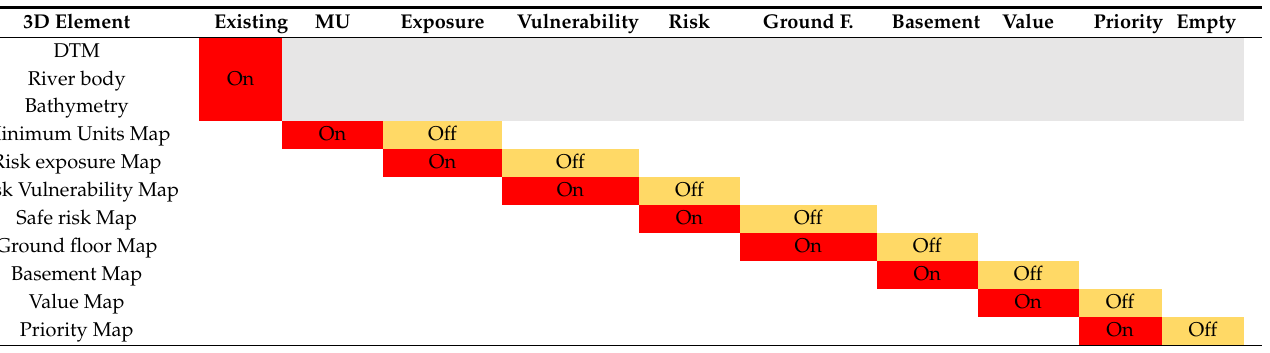
Table 2. Visualization grid of the 3D Maps using the project phases. In red is marked the phase in which a 3D object or a map will start to be displayed and known as a construction phase. In yellow are the demolition phases, namely when they stop being visualized in the project view. In grey are the elements that will always appear in the project view, regardless of the chosen